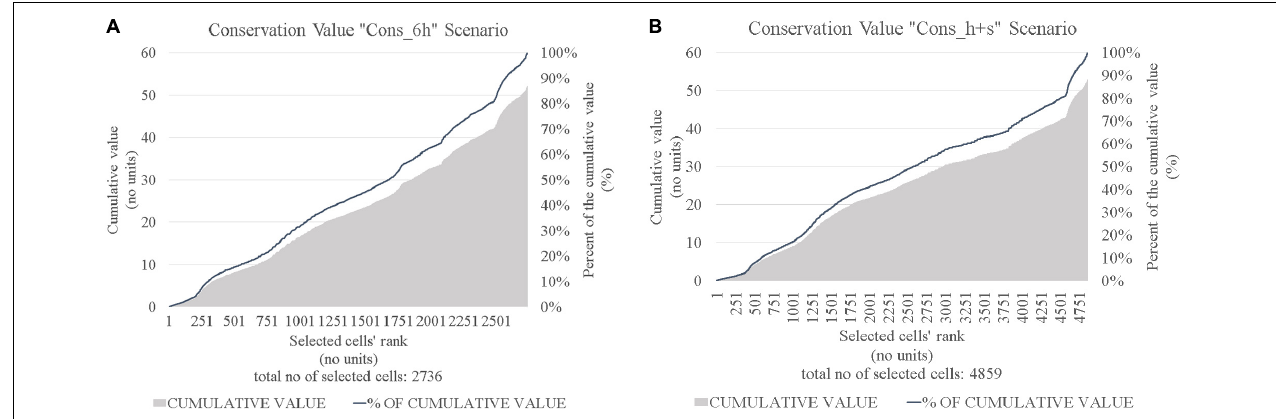
FIGURE 3 | Cumulative distribution of the conservation value of planning units (PUs) selected for conservation. The gray zone expresses the cumulative conservation value, while the blue line demonstrates the percentage of cumulative conservation value per PU. (A) For the “Cons_6h” scenario, the total number of selected PUs is 2,736 out of 32,399 and the cumulative conservation value is 30 (no units). (B) For the “Cons_h + s” scenario, the total number of selected PUs is 4,930 out of 32,399 and the cumulative conservation value is 86 (no units).